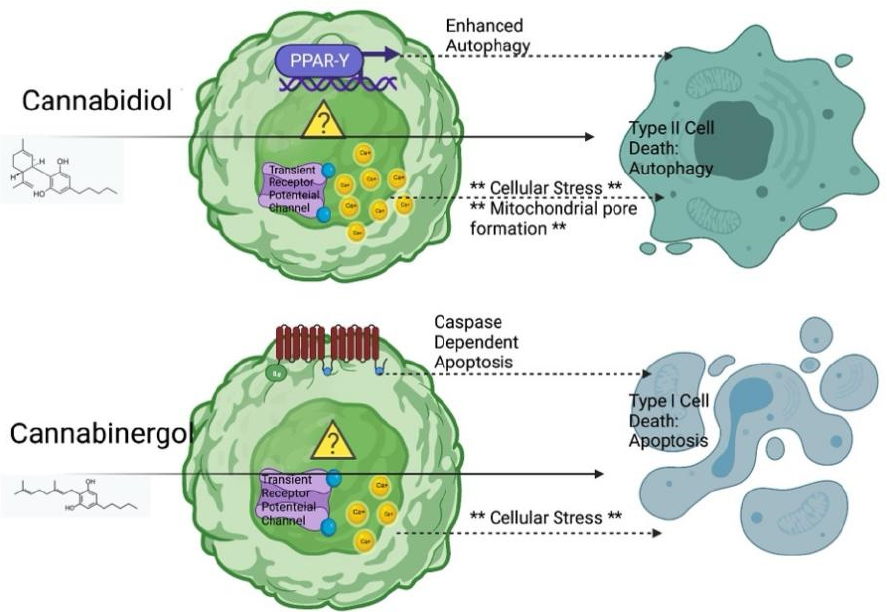
Figure 6. Proposed Mechanism of cannabidiol and cannabigerol against cholangiocarcinoma. Figure is generated from BioRender.com by authors (accessed on 6 June 2021)